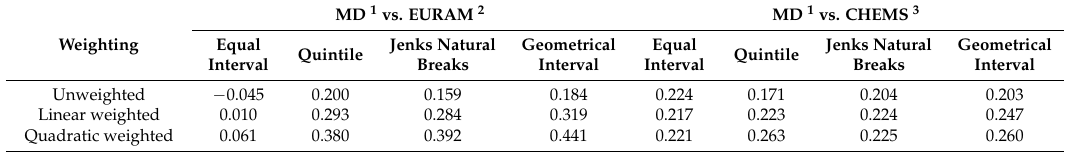
Table 6. Kappa statistics according to the classification methods and the weighted methods. MD 1 vs. EURAM Weighting